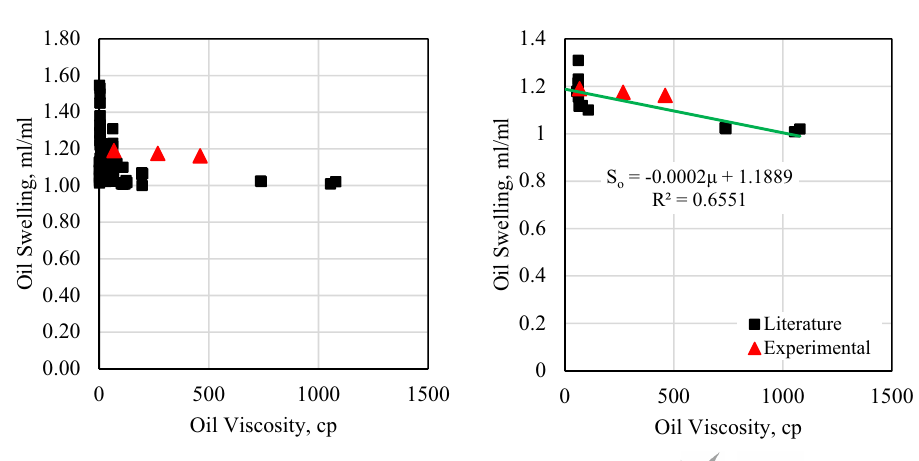
temperature correlation